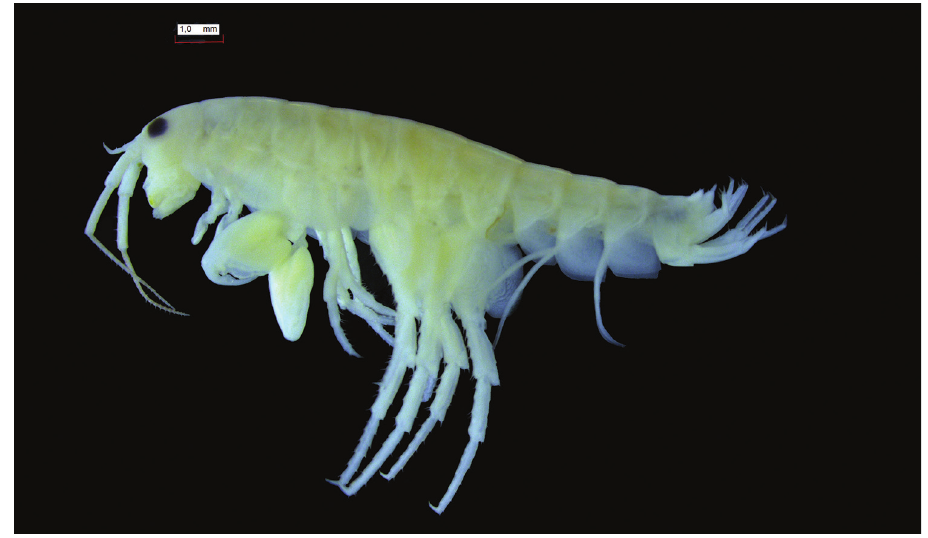
Figure 2. Cryptorchestia ruffoi sp. n., paratype, male (MSNVR). Lateral